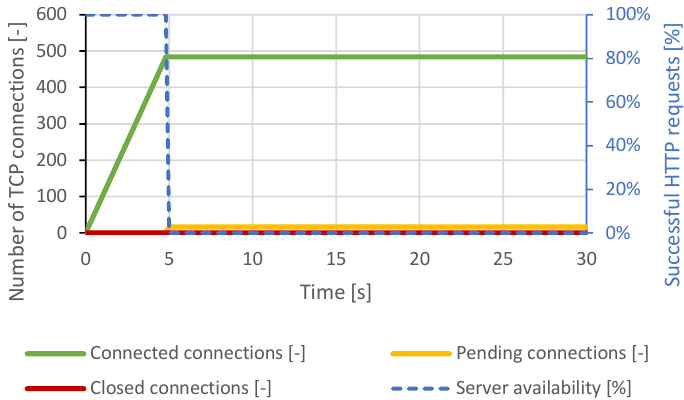
Figure 5. Slow Read attack against Apache